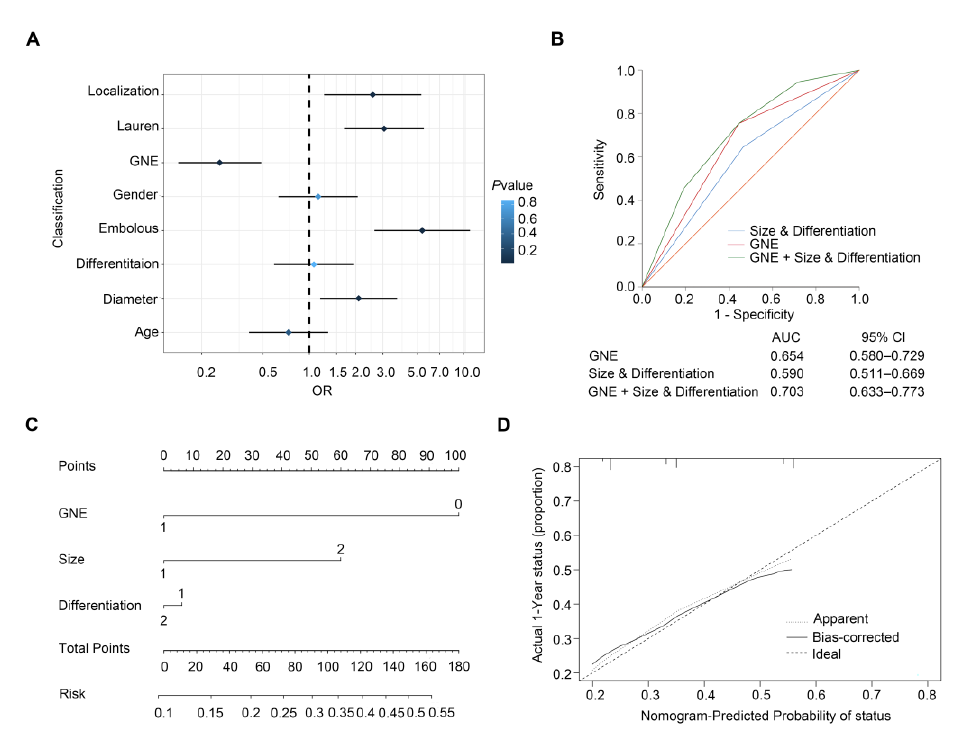
Figure 2. Predictive models for lymph node metastasis in early gastric cancer. ( A ) Forest plot showing the results of univariable logistic regression analysis for LNM in EGC; ( B ) ROC analysis of predictive value for combined size and differentiation with GNE model, size and differentiation model and GNE model in LNM of early gastric cancer patients; ( C ) nomogram generation for prediction of LNM integrating GNE expression (0 and 1 represent low expression and high expression), tumor size (1 and 2 represent ≤ 2 cm and >2 cm) and differentiation (1 and 2 represent poor differentiation and good and moderate differentiation); ( D ) calibration curve for nomogram-predicted probability of LNM.